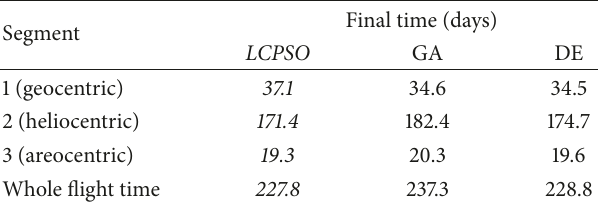
Table 3: Final times for the geocentric, heliocentric, and areocentric